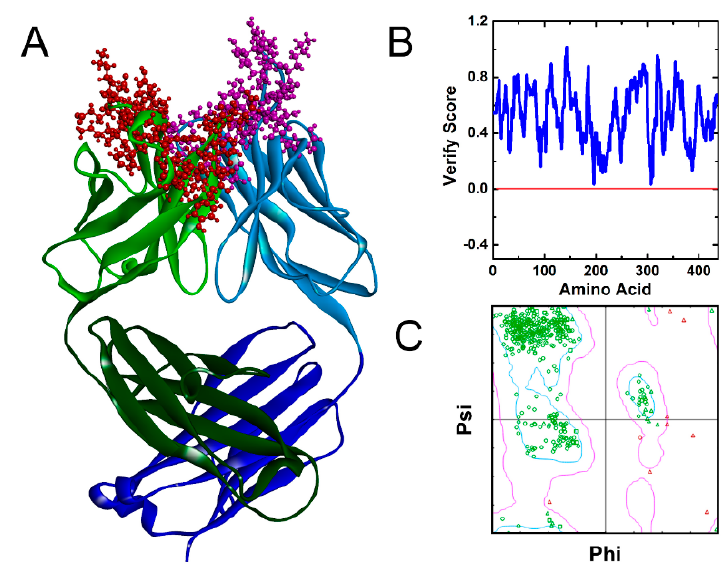
Figure 1. The theoretical model and the structure evaluation of Ab42. ( A ) Ab42 Fab theoretical model with the heavy chain complementarity-determining regions (CDRs) displayed by red color and light chain CDRs displayed by purple spheres respectively; ( B ) Profile_3D verification result of the Ab42 model with residues exhibiting reasonable folding; and, ( C ) the Ramachandran plot analysis shows phi-psi torsion angles of all residues in the structure, and Glycine residues are separately identified by triangles.